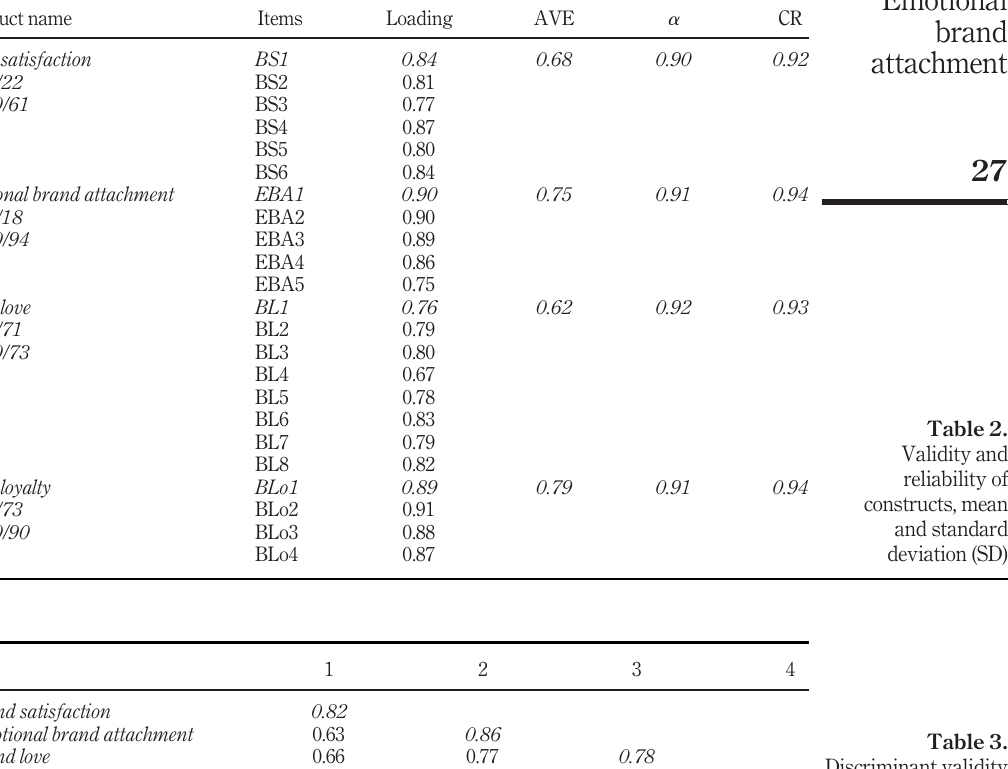
Table 3. Discriminant